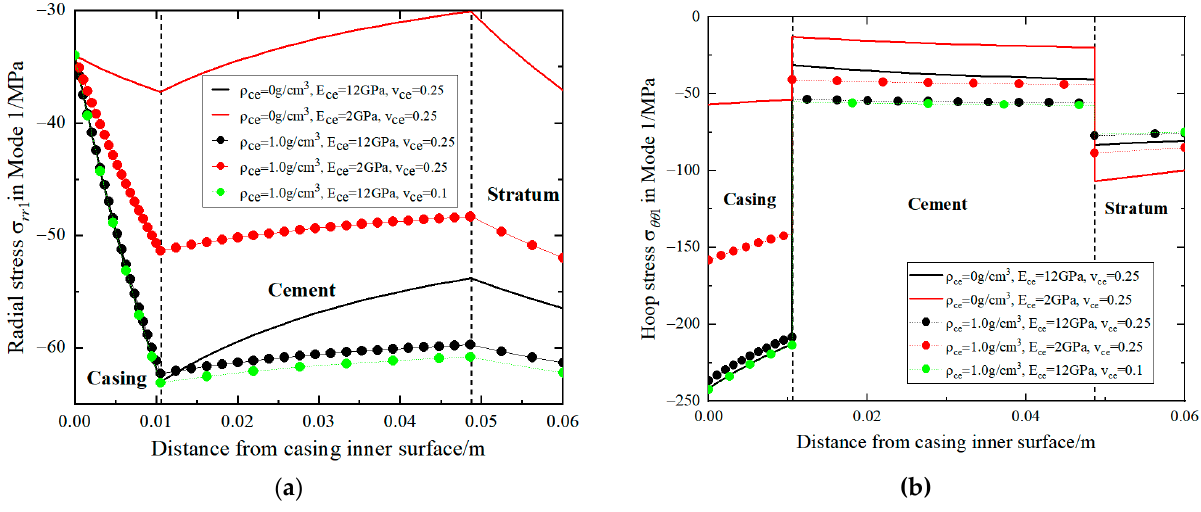
Figure 9. Influence of Young’s modulus and Poisson’s ratio of cement on stress field with and without the initial stress state of cement: ( a ) Radial stress; ( b ) Hoop stress in Mode 1 of Sub-problem I. In this case, a vertical well is considered.